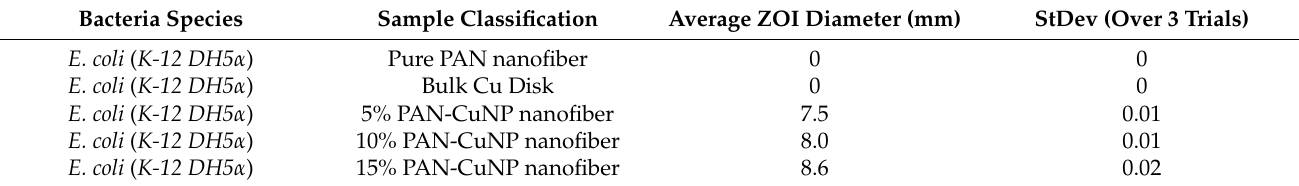
Table 2. Antibacterial Efficiency of PAN-CuNP nanofibers Synthesized from Different wt.% of CuSO 4 and Bulk Copper Disks on E. coli .